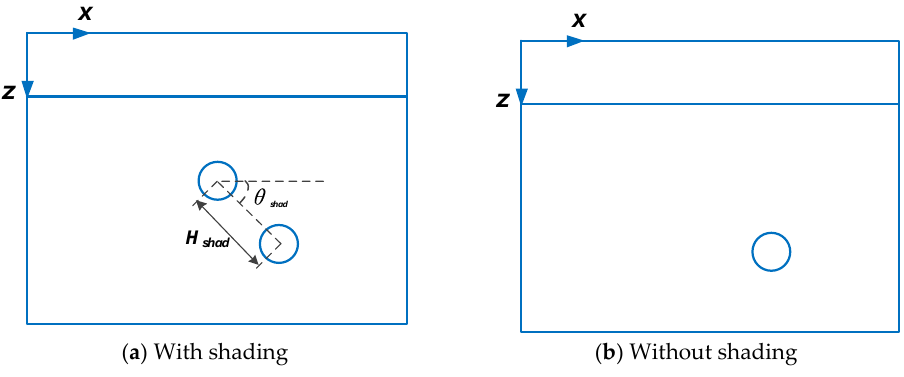
Figure 9. Cross-sectional view of the skin model with parallel PWS vessels.